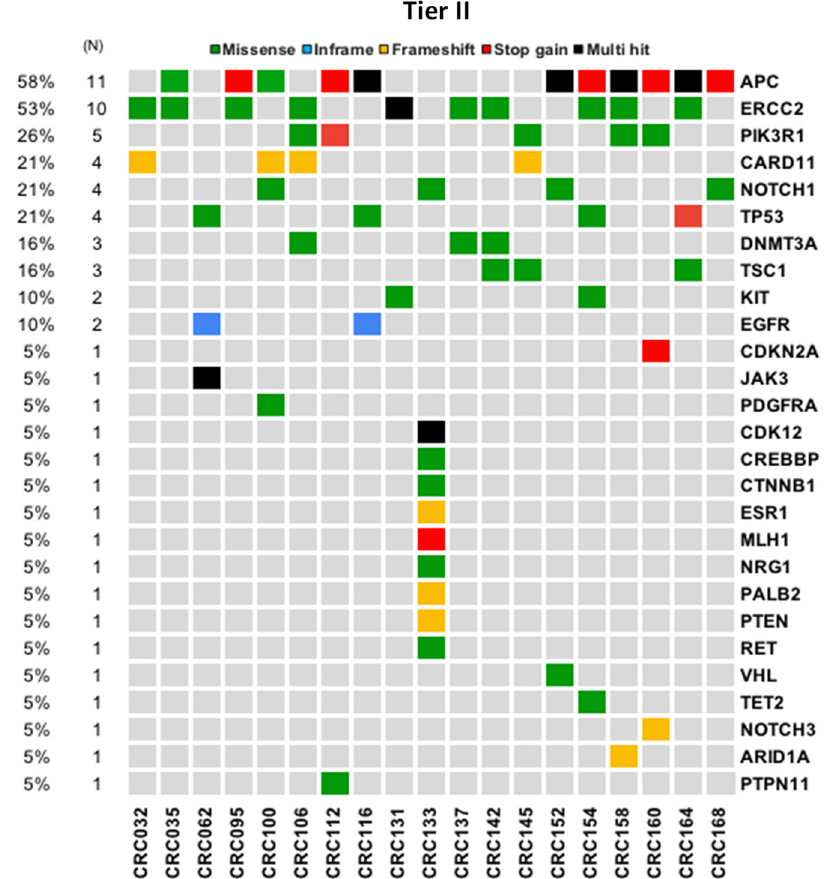
Figure 2. Spectrum of variants in cfDNA of CRC patients according to the cancer-associated clinical significance. The oncoplots show the frequency and distribution of the tier I and II variants detected in cfDNA of CRC patients. “Multi hit” indicates that more than one variant in a gene was found in the same patient. The number ( N ) and percentage of patients is shown on the